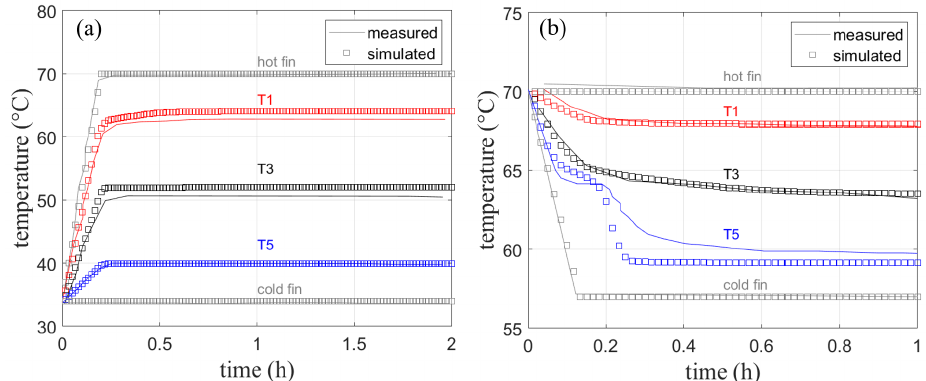
Figure 15. Measured [4] and simulated temperature curves with fins for ( a ) melting and ( b ) solidifi- cation. Note, that for melting ( a ), only sensor T1 is placed within the melting zone.